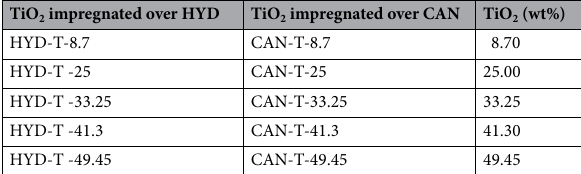
Table 1. Labeling of samples of the hybrid